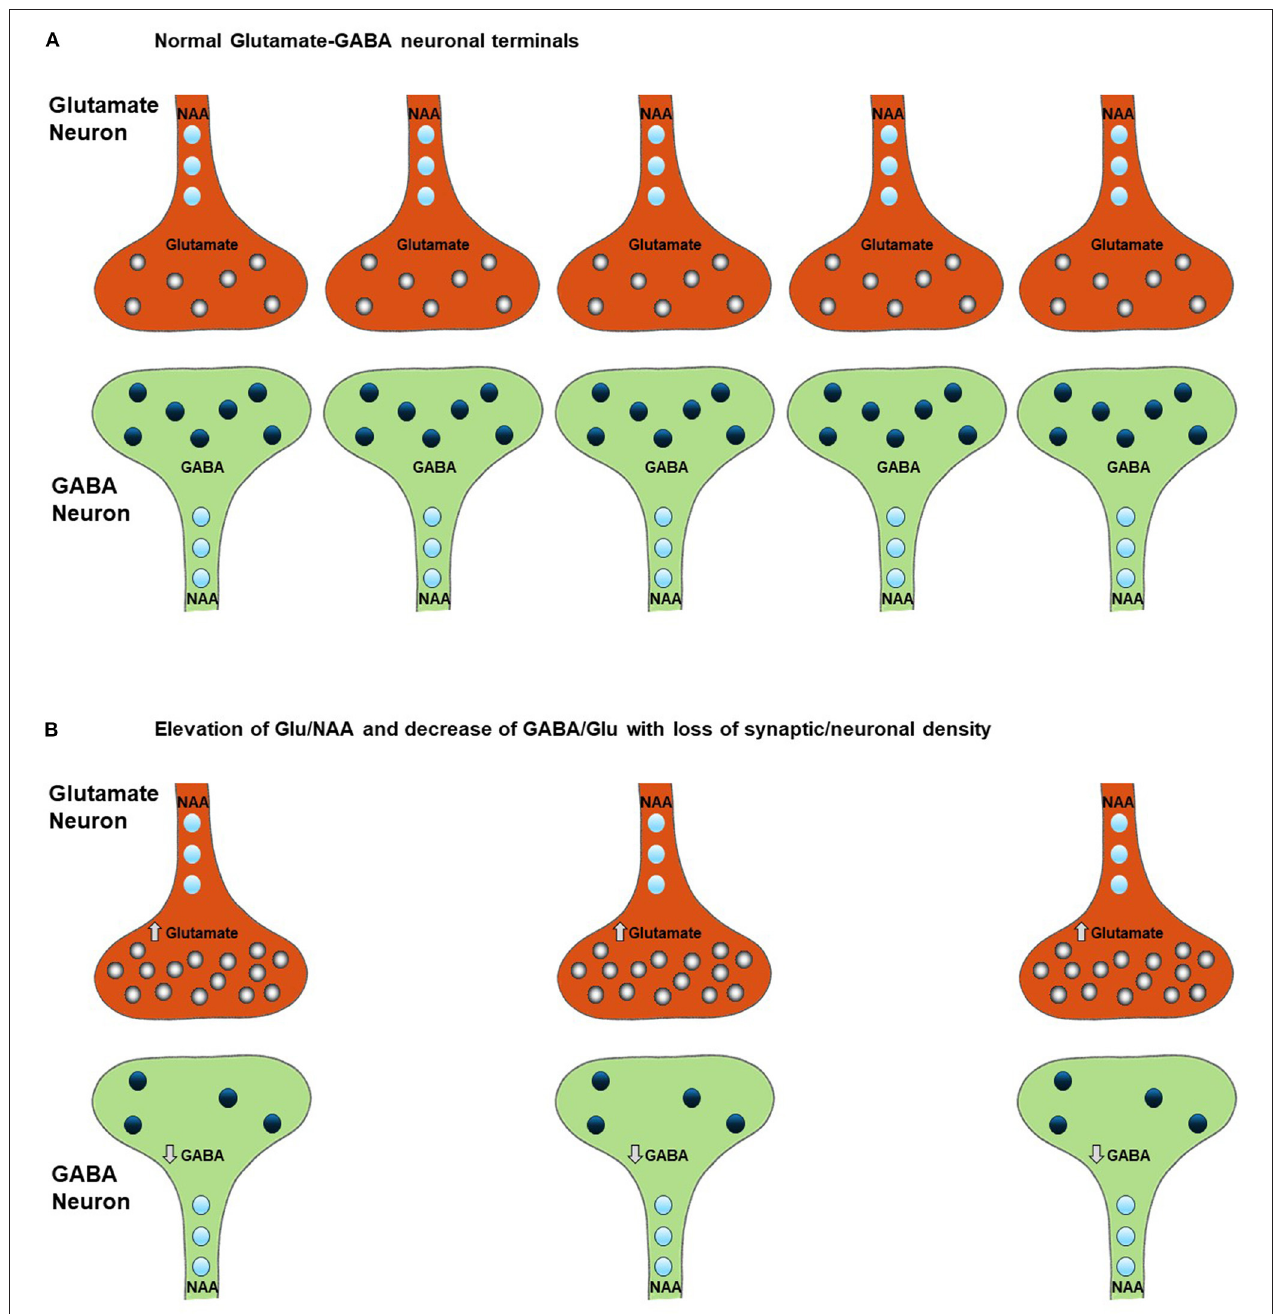
FIGURE 2 | Effect of neuronal and synaptic loss on MRS measured levels of Glx, glutamate, GABA, and NAA. Chronically elevated neuronal excitability leads to a decrease in neuronal density (B) relative to normal conditions (A) as a result of glutamate excitotoxicity leading to Ca 2 + induced apoptosis. This excitotoxicity is triggered by an increase in intracellular glutamate, as shown in Figure 1C , and is accompanied (and potentially preceded) by a decrease in intracellular GABA, as described in section Potential Alterations in the GABA and Glutamate Balance in ALS and Impact on Cellular GABA Concentration. Comparison of figures (A,B) shows that the increase in glutamate and decrease in GABA due to disease progression may not be detected due to the reduction in their 1 H-MRS measured levels as a consequence of loss of neurons However the changes due to ALS within the neurons of the ratios of Glu/NAA and GABA/Glu will not be effected by the drop in neuronal density. Therefore, these ratios may be more sensitive to the specific neuronal changes associated with the progression of the disease, which the results of our review of the literature support (see section A Model for Changes in MRS Measured Glutamate, GABA, and Glutamine Levels During the Progression of ALS for a more detailed explanation of the impact of a change in neuronal density on the 1 H MRS